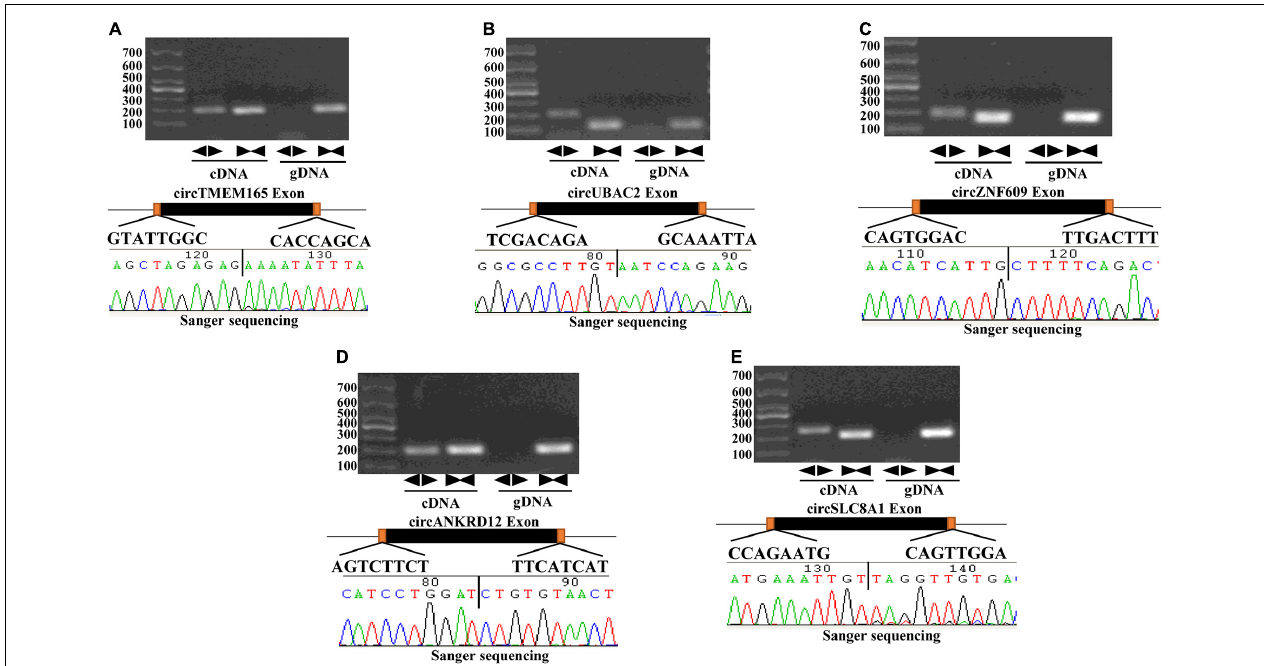
FIGURE 2 | Validation of the circular structure of circRNA. circRNAs exist in human myocardial cell line (AC16). Clear single bands were amplified from the cDNA of AC16 by divergent primers, while they could not be amplified from gDNA. Sanger-Seq validated the head-to-tail junction of circRNAs. circTMEM165 (A) , circUBAC2 (B) , circZNF609 (C) , circANKRD12 (D) , circSLC8A1 (E) exists in human myocardial cell.